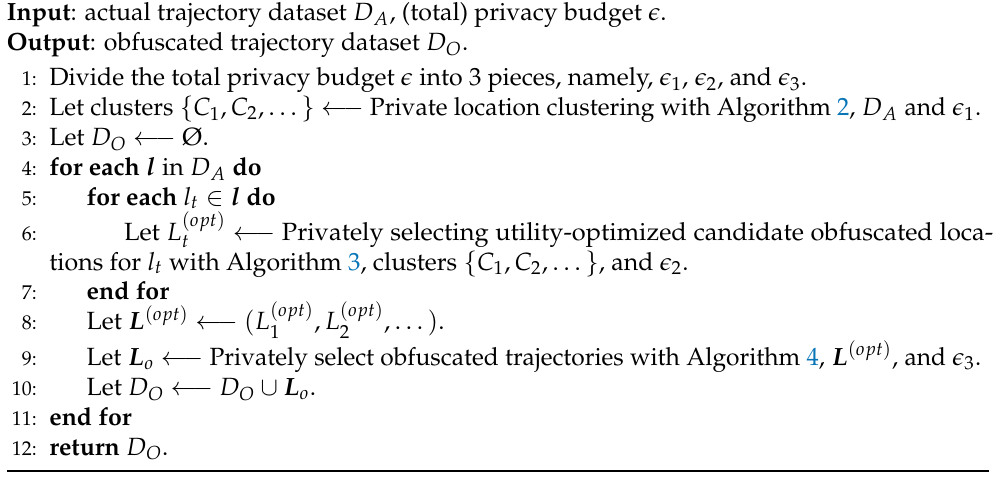
Algorithm 1 Utility-optimized and differentially private trajectory synthesis